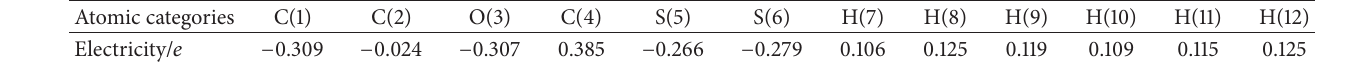
Table 4: Mulliken charge distribution of ethyl xanthate molecules.